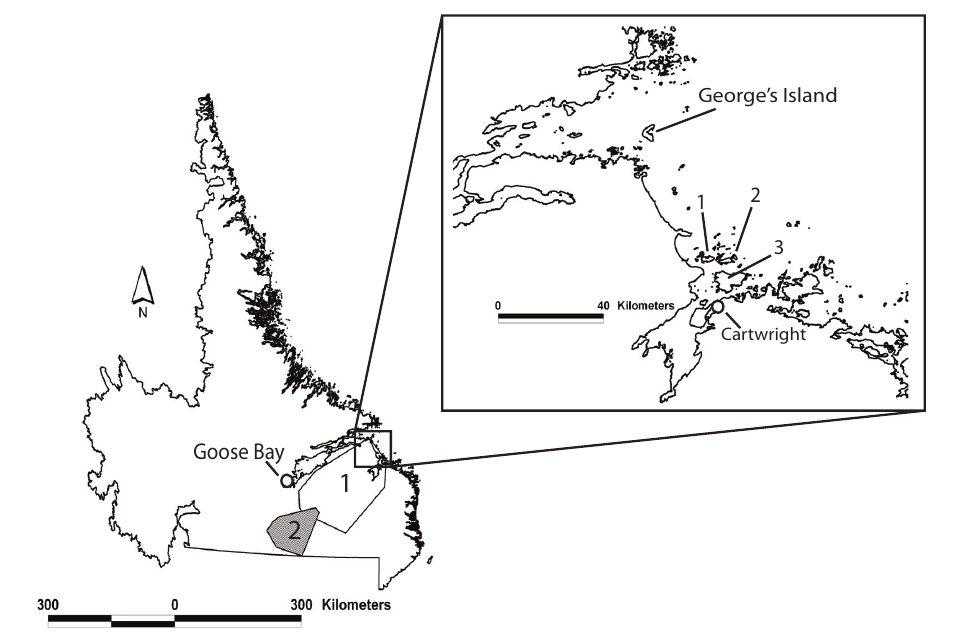
Fig. 1 Map of Labrador, Canada showing ranges of two woodland caribou subpopulations ( Rangifer tarandus caribou ): (1) Mealy Mountain caribou range (32 536 km 2 ) and (2) Joir River caribou range (7057 km 2 ). Inset shows George’s Island and Horsechops (1), Newfoundland (2), and Huntington (3)